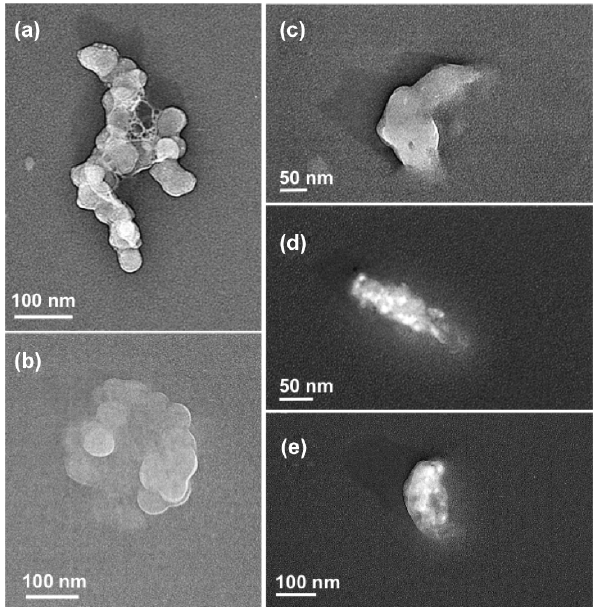
Figure 7. Examples for particles built up by aggregated subunits, observed with TEM: (a, b) pure “aggregate” particles and (c, d, e) “aggregate with film” particles, comprised of “aggregate” parti- cles covered with a thin film of